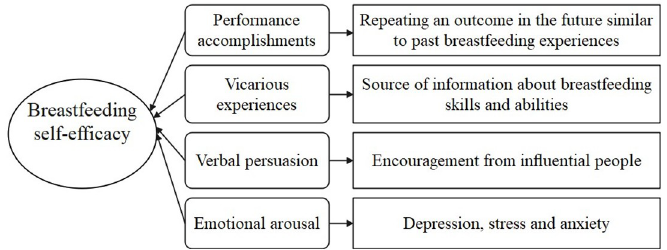
Fig 1. Diagrammatic representation of the Dennis breastfeeding self-efficacy